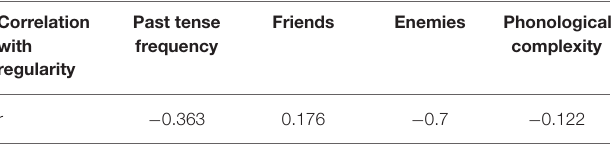
TABLE 2 | Correlations between regularity and the statistical properties of verbs in the training data. Correlation with